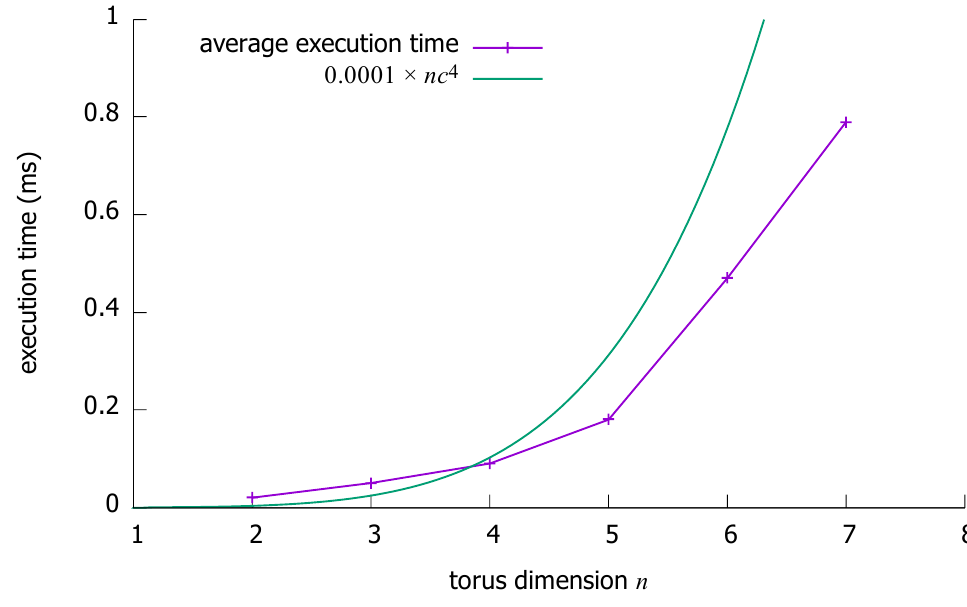
Figure 10. Empirical evaluation: average execution time to solve one problem instance with the proposed algorithm in an ( n , max { 5, n + 1 }